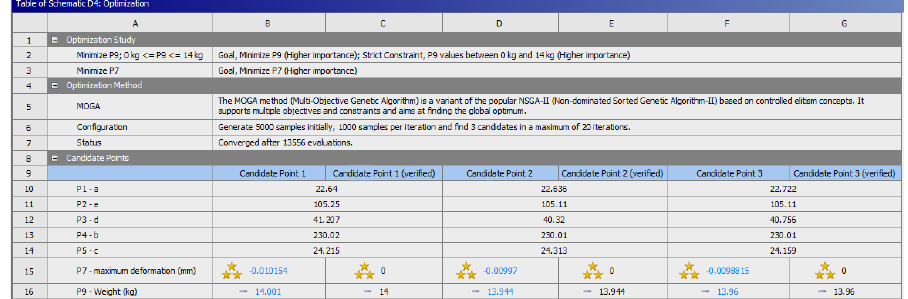
Figure 27. Optimization result drive rod.